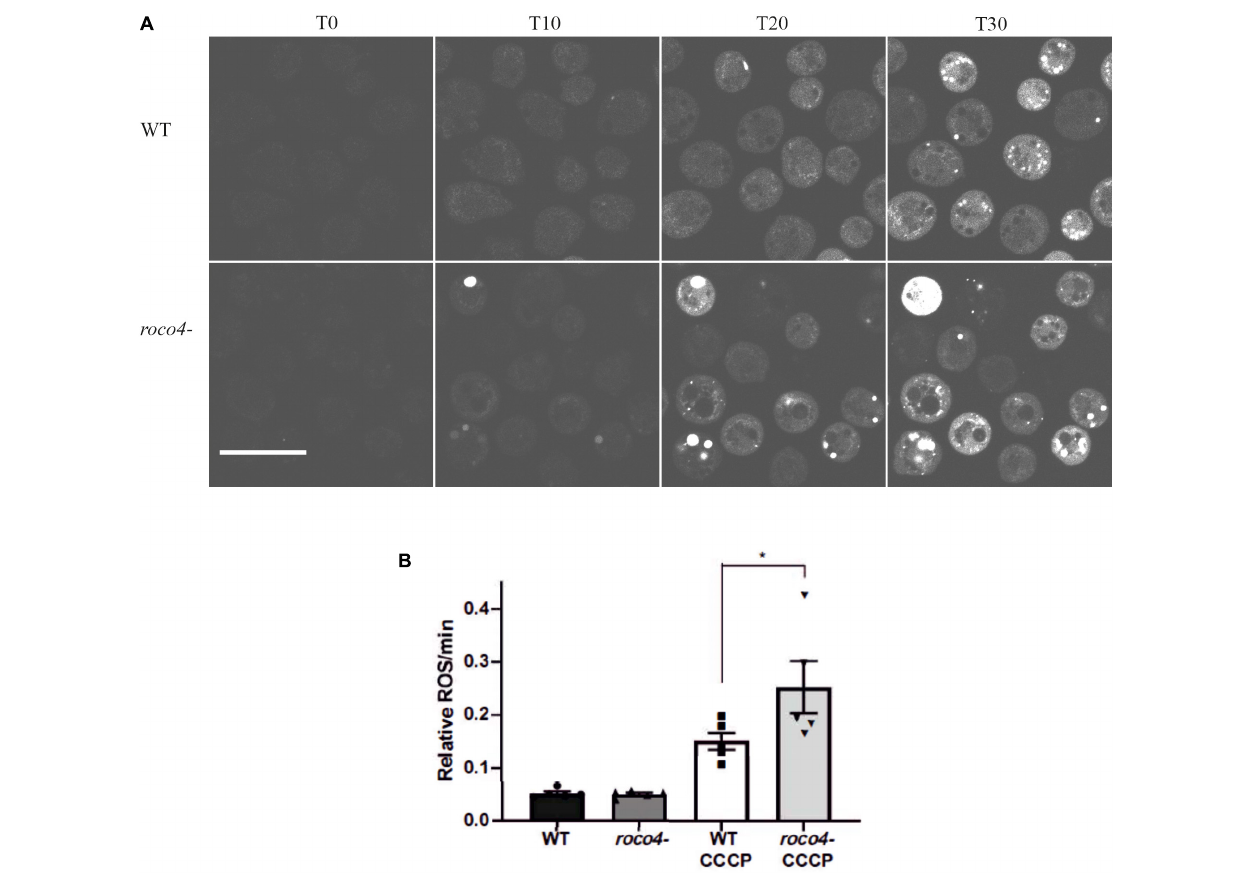
FIGURE 2 | ROS production in D. discoideum cells. (A,B) Six hours starved WT and roco4- cells were incubated with DCF-DA. (A) After addition of CCCP images were taken at the indicated time points (“T” minutes). Scale bar indicates 20 µ m. (B) Total levels of ROS production were determined by measuring the intensity of the DCF signal using a microplate reader (Synergy HTX). Results are displayed as relative values to each other based on the increasing signal intensity. Shown are the means of 5 independent experiments, * indicates P < 0.05 difference from the WT control in a paired students t